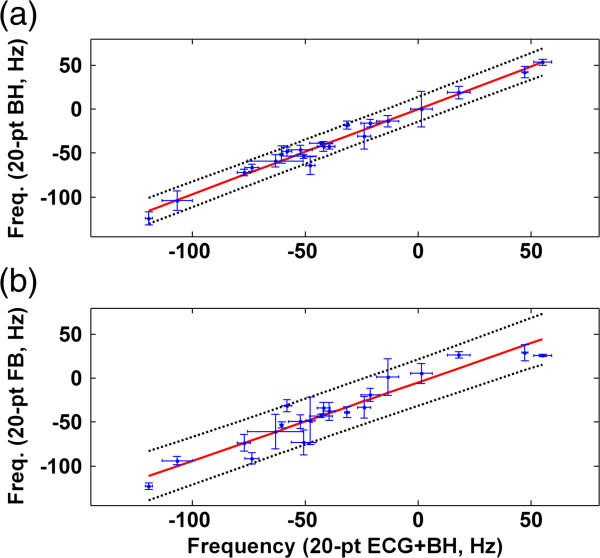
Group analysis of 20-pt bSSFP-L sweep scan datasets (a) 20-pt BH vs. 20-pt BH + ECG, (b) 20-pt FB vs. 20-pt BH + ECG(blue dot and error bar: mean and standard deviation of the Δf values obtained in three repeated scans, red line: linearly fitted lines, black dotted line: 95% prediction interval).